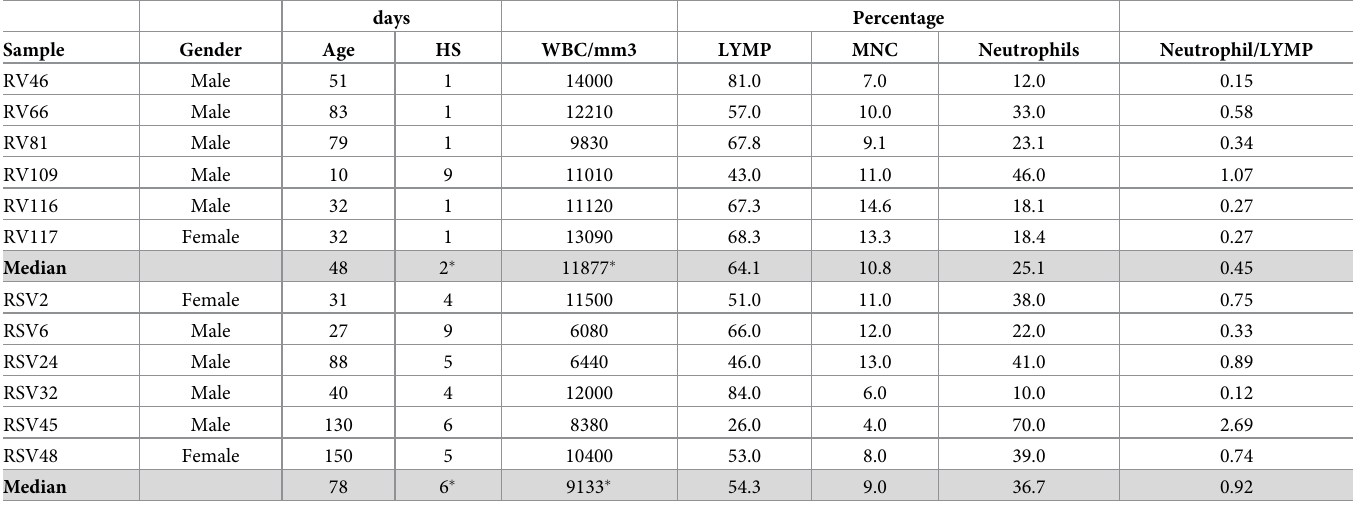
Table 1. Demographic and clinical data of infants with HRSV or HRV